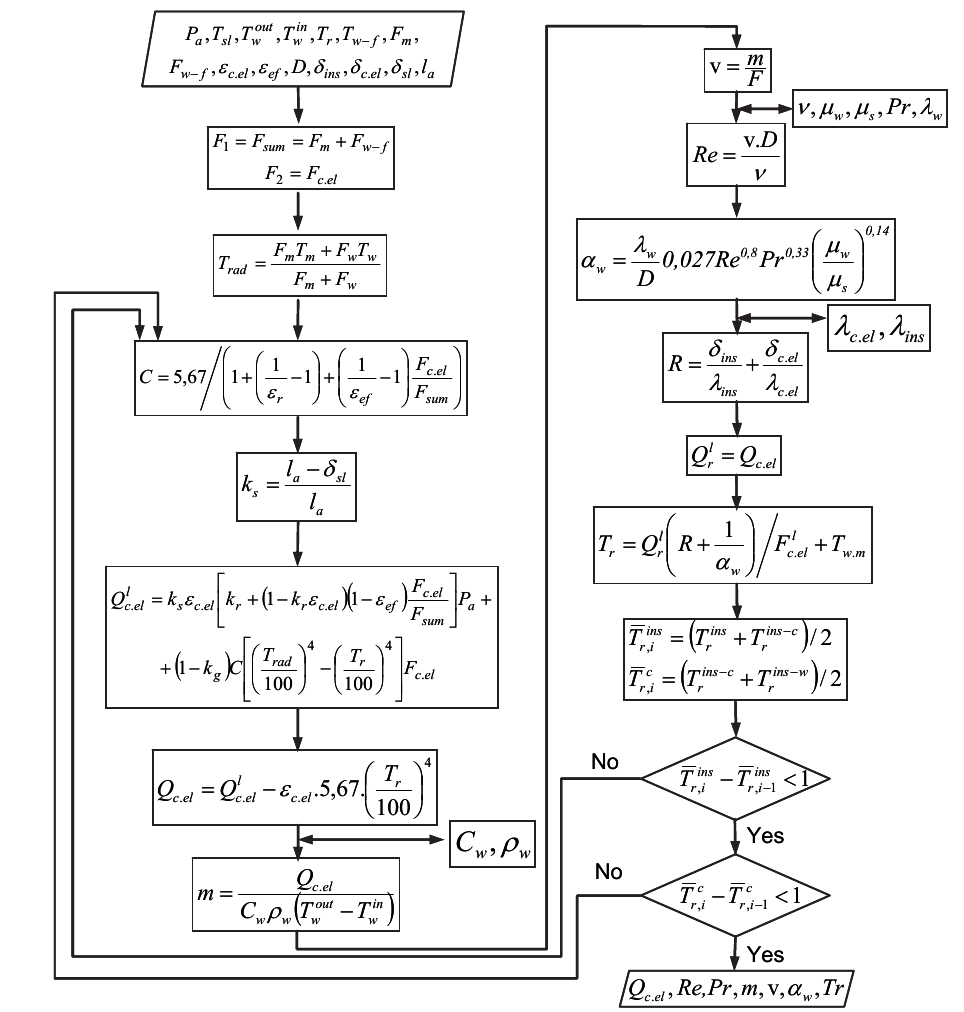
Figure 3: Simplified block diagram of the numerical